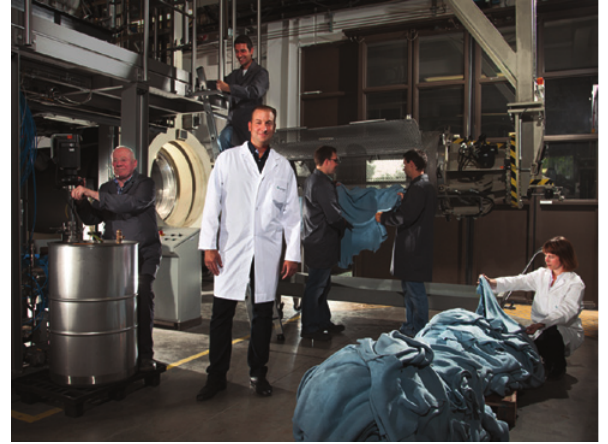
Figure 3: Leather tanning by Fraunhofer UMSICHT: 40% less chrome, zero water, no salt, five times faster. © Fraunhofer